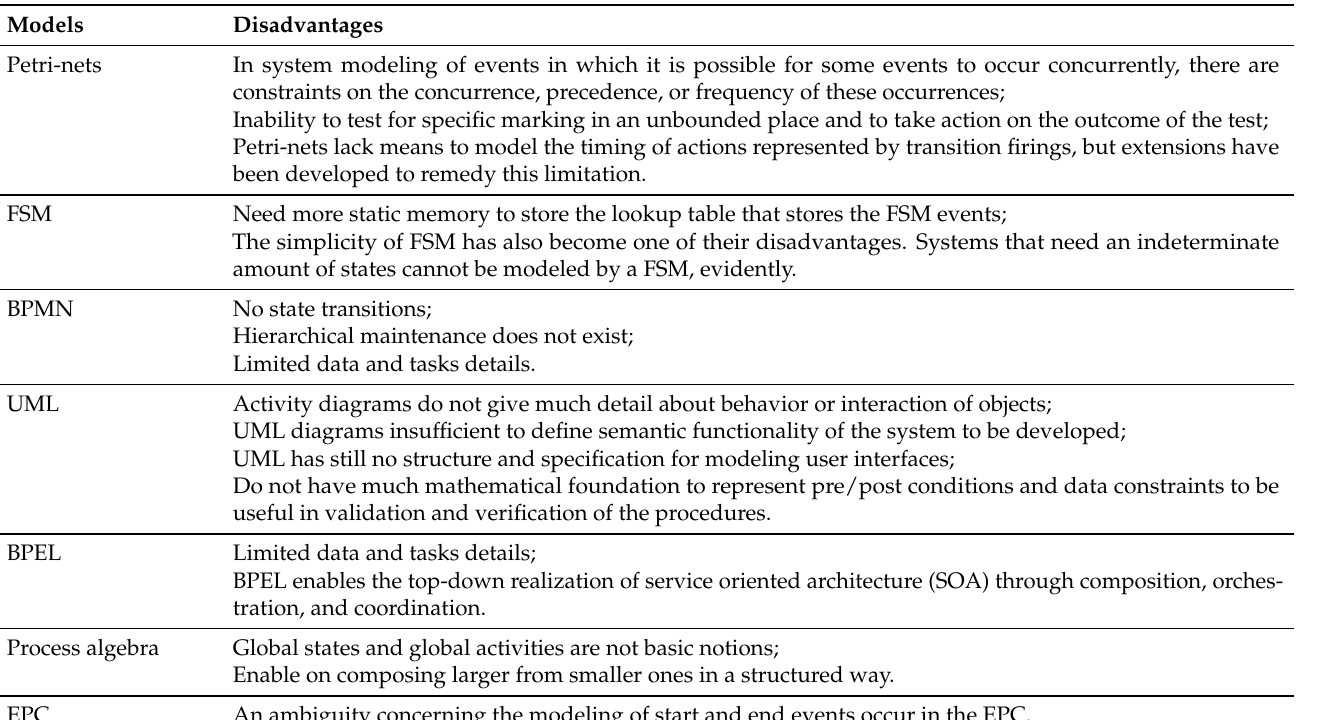
Table 2. BP models’